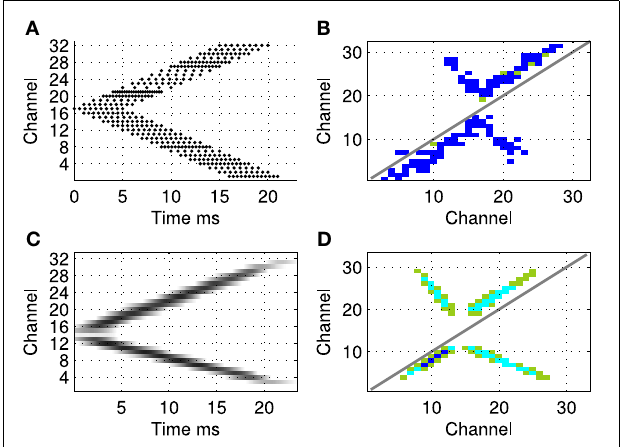
FIGURE 11 | Comparison between hardware result using a synthetic stimulus pattern (A,B) and learning prediction using a real sound file (C,D). Top row shows raster of synthetic exposure stimulus (A) and resulting network connectivity after exposure (B) for hardware network—these figures are taken from Sheik et al. (2011). Bottom row shows spectrogram of comparable sound file (C) and the analytically predicted pattern of connectivity (D) based on correlations in the stimulus representation as described in section